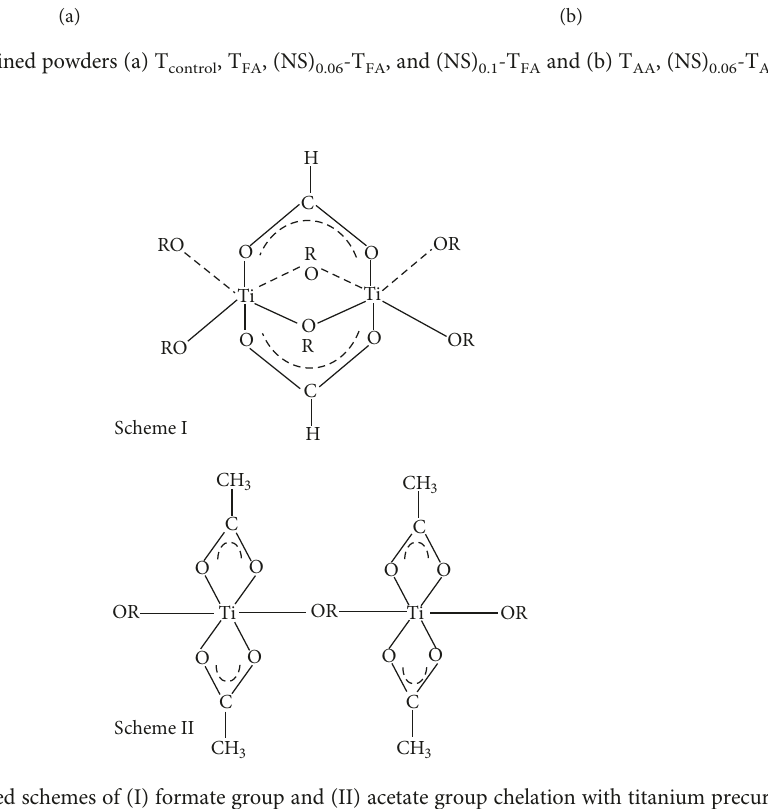
-T and (b) T 0.1 FA